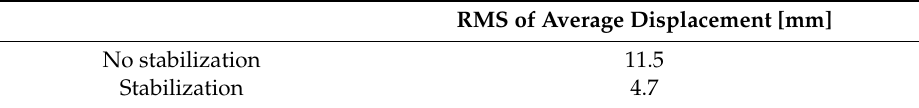
Figure 6. Displacement measured in-situ with stabilization (red) and without stabilization (blue), with smoothing (bold lines) and without smoothing (thin lines). Table 2. RMS (Root mean square) of the average displacement measured at 30 km/h.